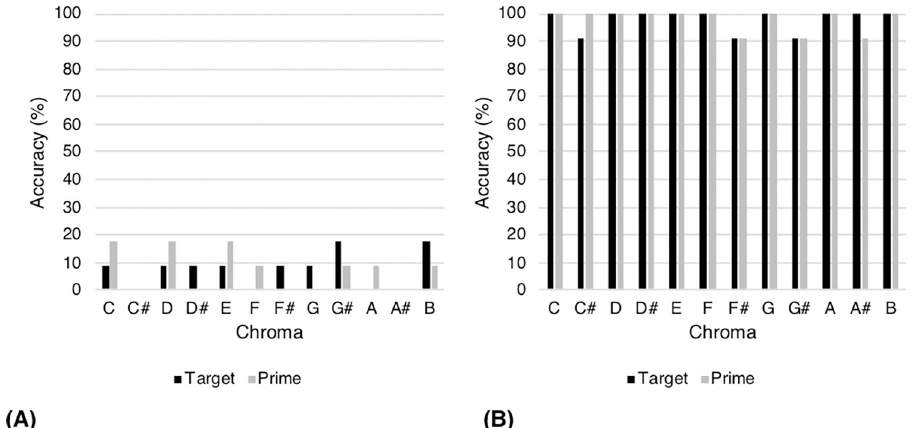
Fig 6. Accuracy profiles for a typical (a) non-AP participant (Participant 24; AP-P task accuracy 7.58%) and (b) AP participant (Participant 30; AP-P task accuracy 97.73%). Target bars refer to the percentage of those trials for which each chroma was a target that was correctly identified by the participant. Prime bars refer to the percentage of those trials for which each chroma was a prime that preceded a correct target identification by the participant. https://doi.org/10.1371/journal.pone.0273828.g006 Figs 7 and 8 illustrate chroma accuracy profiles for two QAP participants (for additional accuracy profiles, see S5–S10 Figs). For participant 32 (Fig 7), target chroma significantly pre- dicted the likelihood of a correct response, such that several chroma were less likely than C to result in correct target identification. No significant primes were identified. For participant 27 (Fig 8), significant differences among chroma were identified for both targets and primes, such that both target chroma and prime chroma predicted the likelihood of a correct response.